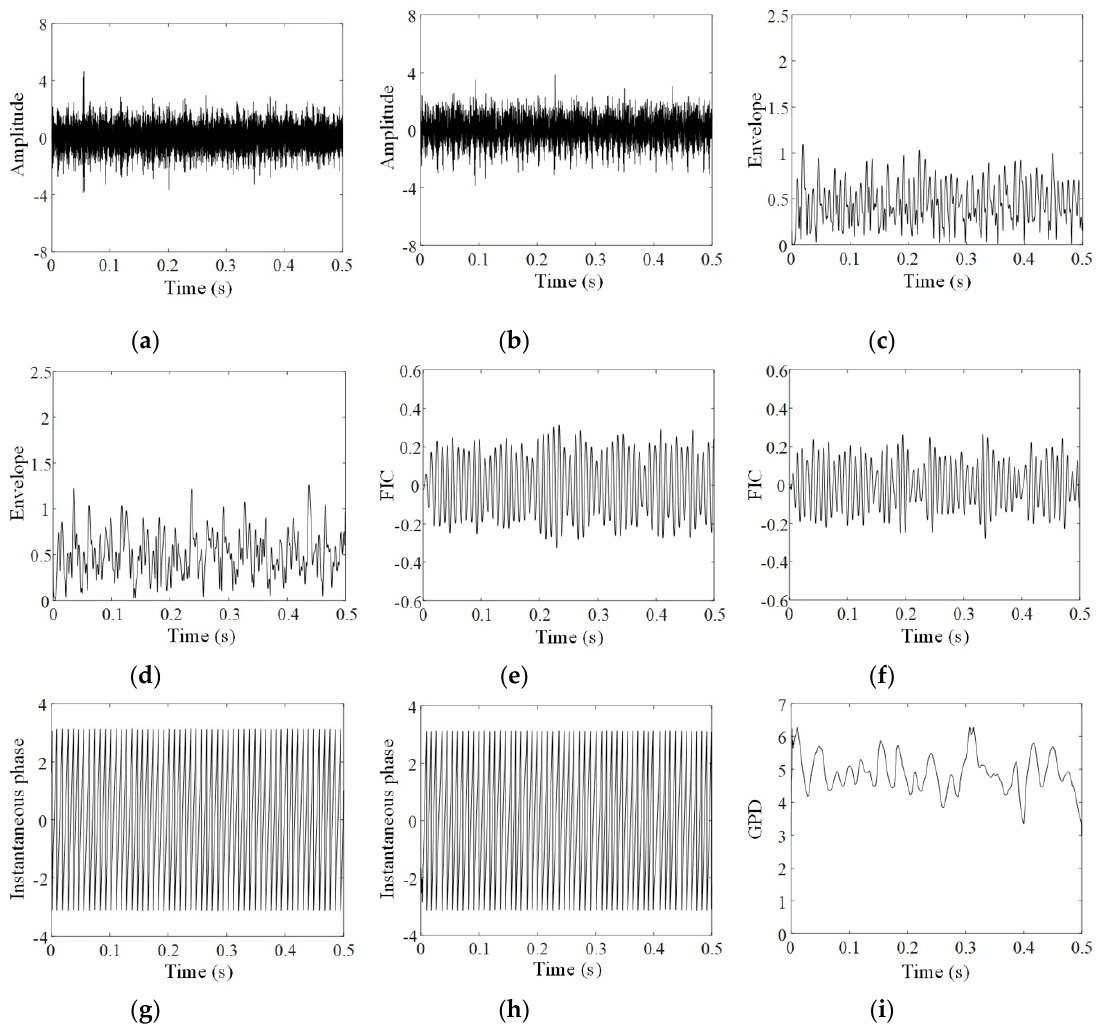
Figure 5. PSA of the 90th minute vibration signals: ( a ) horizontal signal; ( b ) vertical signal; ( c ) envelope of horizontal signal; ( d ) envelope of vertical signal; ( e ) FIC of horizontal signal; ( f ) FIC of vertical signal; ( g ) instantaneous phase of horizontal FIC; ( h ) instantaneous phase of vertical FIC; ( i ) GPD of vibration signals.